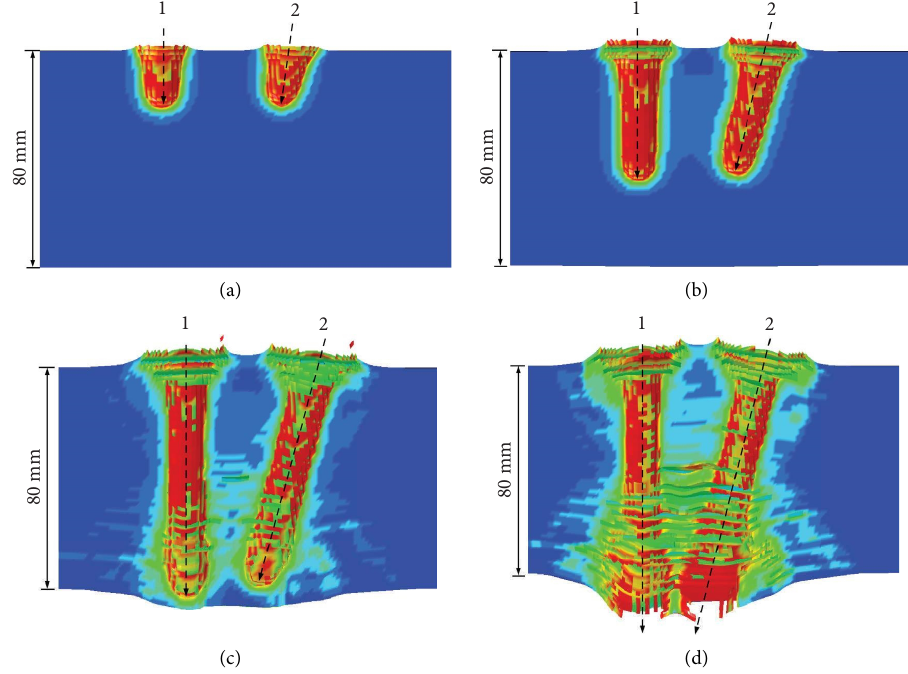
Figure 16: Cloud chart of joint damage strain process in the tunnel area. (a) 0.025ms. (b) 0.075ms. (c) 0.225ms. (d)